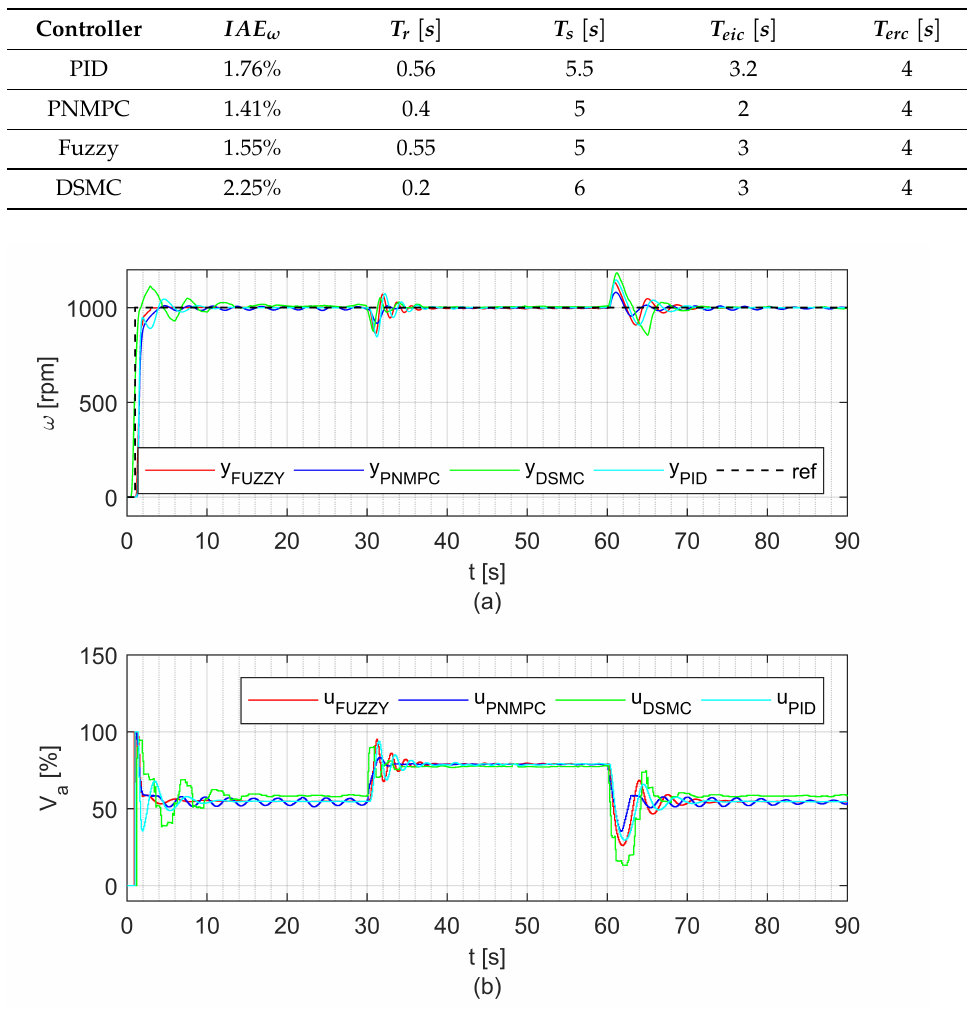
Figure 15. Output signal of the DC motor system with amplitude variation of the reference signal: ( a ) speed and ( b ) armature